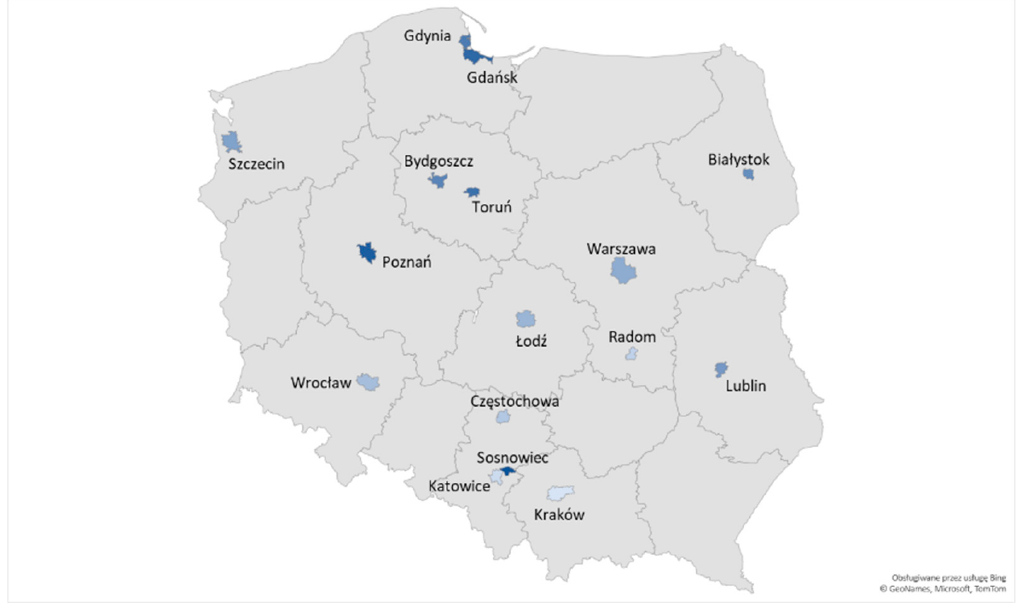
Figure 2. Cities in Poland with a population of over 200,000 inhabitants. Source: own elaboration based on data from Local Data Bank.